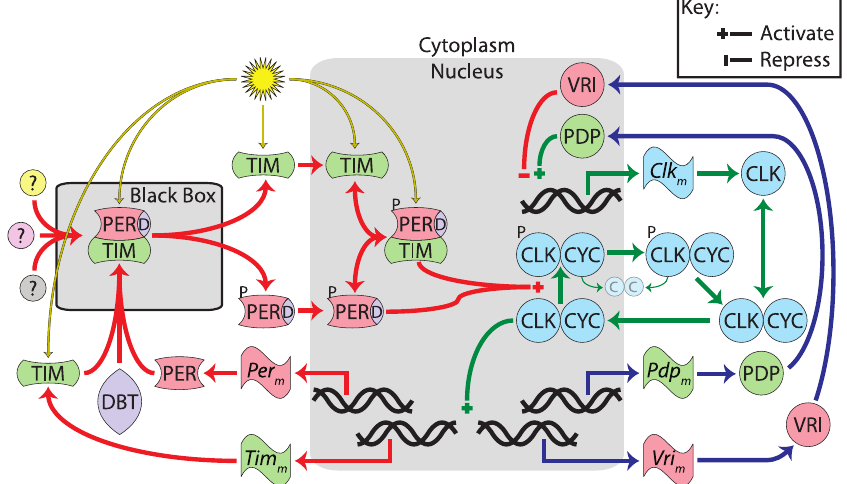
Figure 1. A Detailed Framework of Circadian Rhythms in